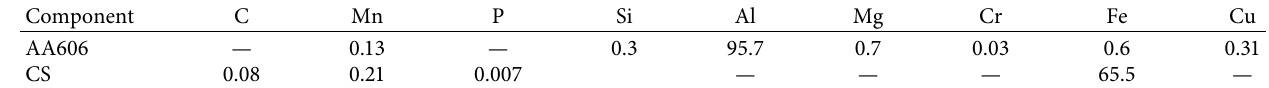
Table 1: Chemical composition of BMs.